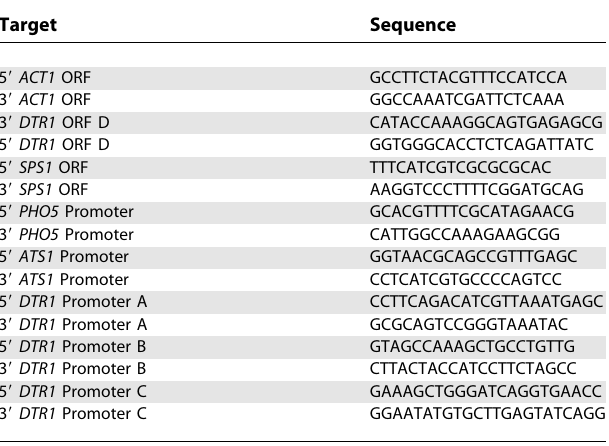
Table 3. Oligonucleotides Used in This Study